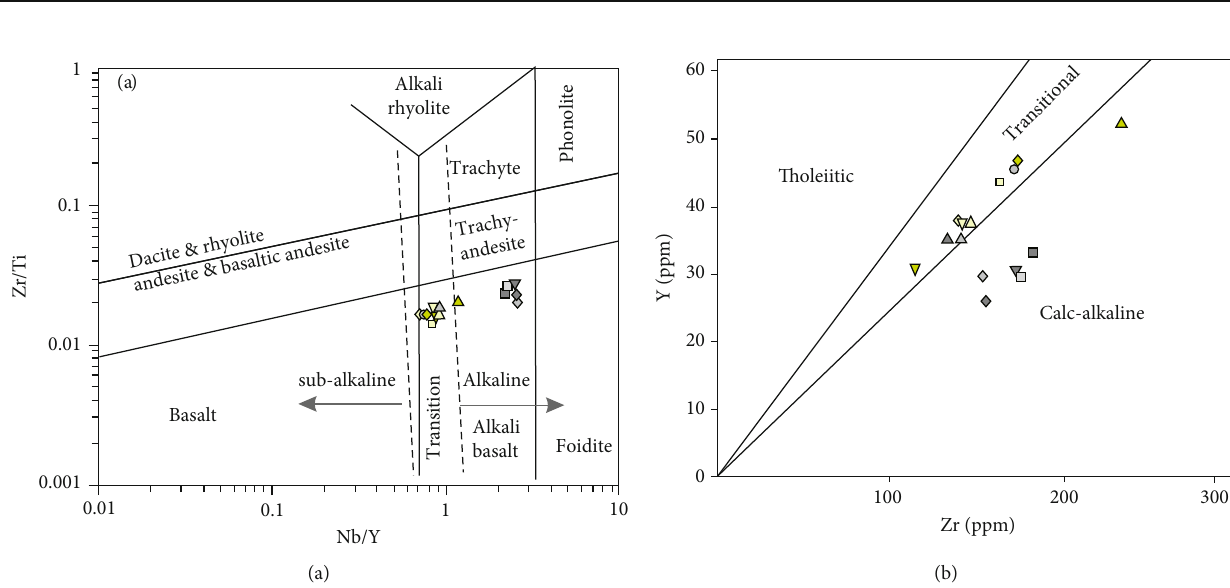
Figure 4: (a) Nb/Y vs. Zr/Ti and (b) Y vs. Zr discriminations for the Paleogene igneous rocks from the Huimin Sag. The boundary lines in (a) and (b) are from Pearce [26] and Miyashiro [27],